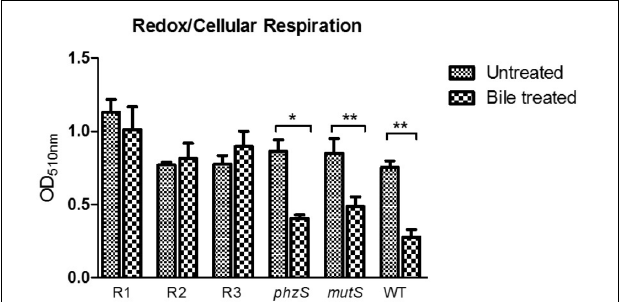
FIGURE 5 | Tetrazolium violet redox assay revealing the lack of repression of redox in the presence of bile in the red pigmented variants with a repression of redox evident in the phzS mutant. Data is the mean of at least three independent biological replicates. Statistical analysis was performed by Student’s t -test ( ∗ p ≤ 0.05; ∗∗ p ≤